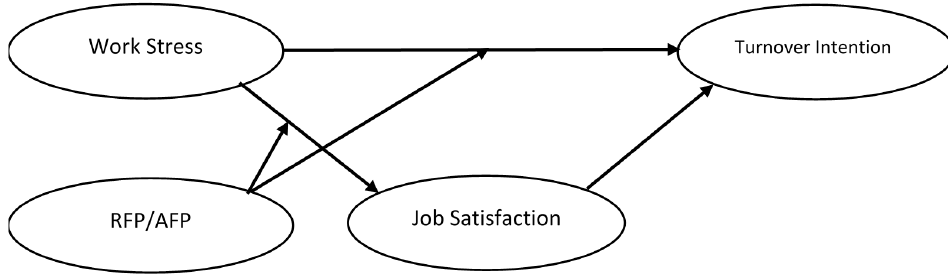
Figure 1. Theoretical